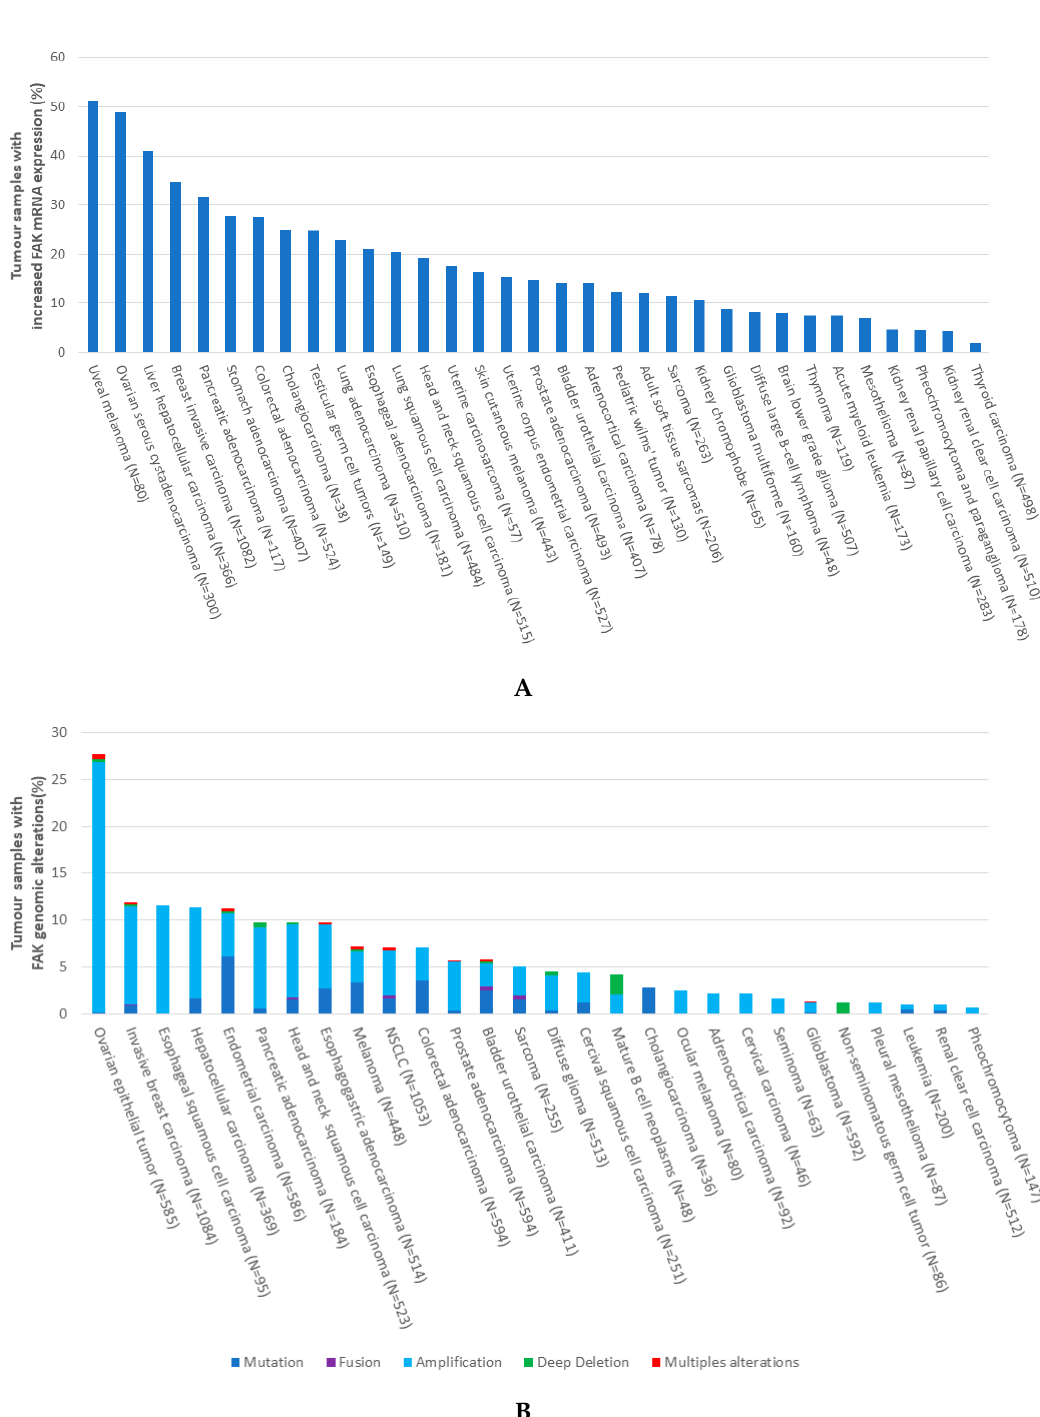
Figure 3. ( A ) Frequency of increased focal adhesion kinase (FAK) expression at mRNA levels in human cancers. The Cancer Genome Atlas (TCGA) was queried using cbioportal.org to determine the percentage of tumor samples with increased levels of FAK mRNA expression. Search criteria included mRNA expression data (Z-scores for all genes) and tumor datasets with mRNA data. N = number of cancers analysed in the TCGA. ( B ) Frequency of focal adhesion kinase (FAK) genomic alterations in human cancers. The Cancer Genome Atlas (TCGA) was queried using cbioportal.org to determine the percentage of samples with FAK genomic alterations (mutations, fusions, amplifications, deep deletions, multiples alterations) in different cancers. Search criteria included PTK2 (FAK). N = number of cancers analysed in the TCGA.